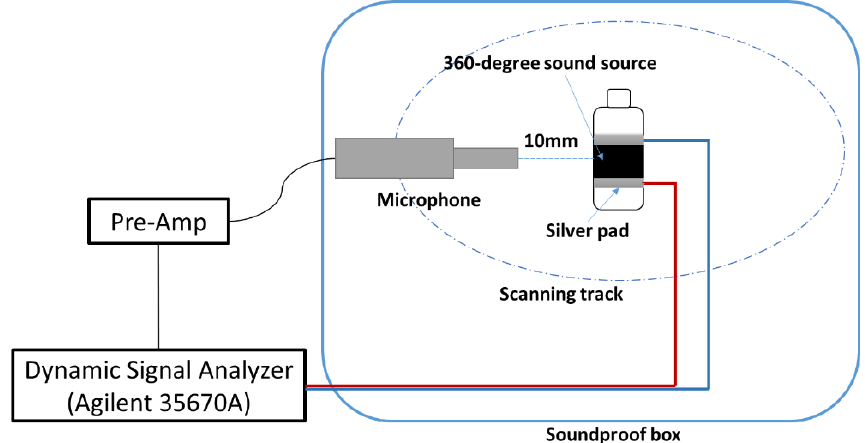
Figure 2. Schematic illustration of the testing platform of 360-degree thermal sound source.